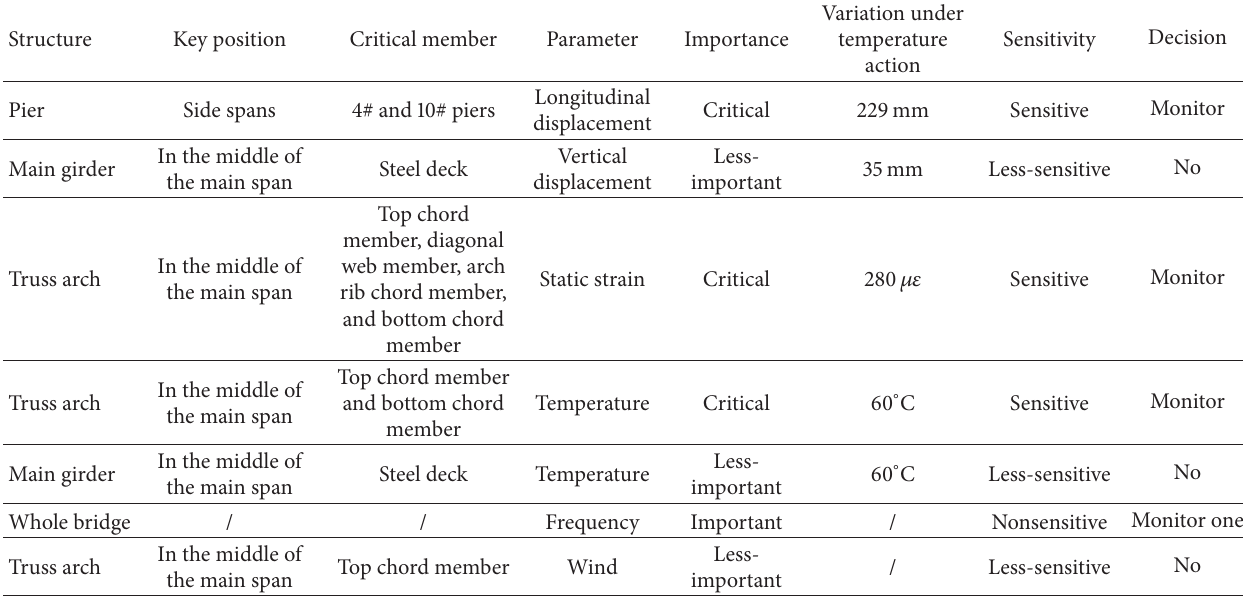
Table 1: Sensitivity analysis of bridge parameters for SHM